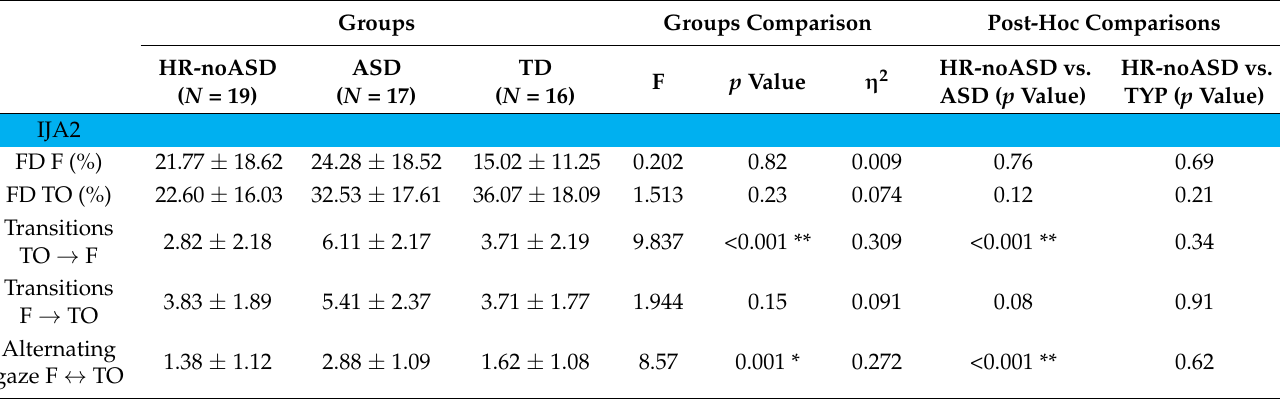
Table 3. Transitions, alternating gaze and fixation for the joint attention phase of the IJA2. Groups Groups